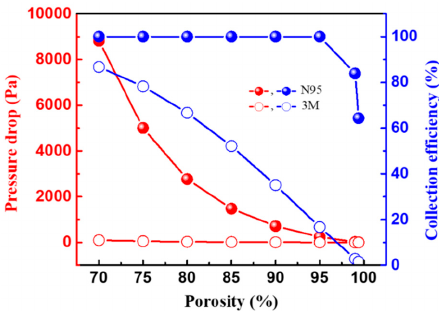
Figure 4. Theoretical analysis of collection e ffi ciency and pressure drop of the N95 and 3M filters as a function of filter porosity.